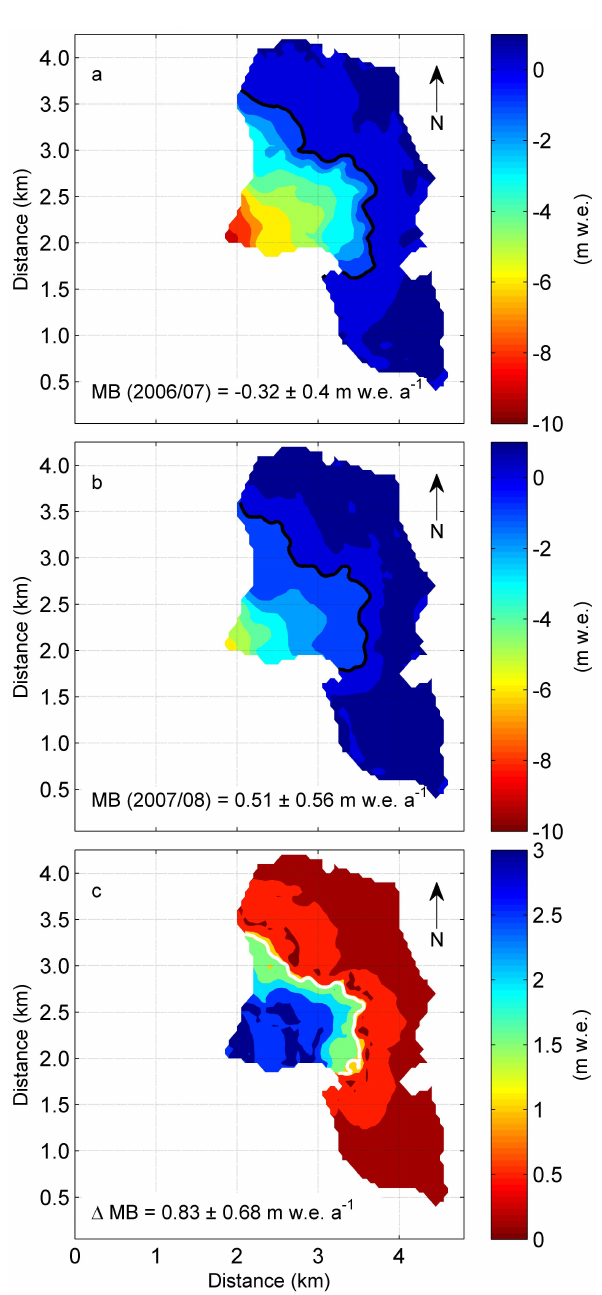
Fig. 6. Annual mass balance for (a) September 2006 to August 2007 and (b) September 2007 to August 2008, showing the ELA as a black line. Given uncertainty values only reflect uncertainties in internal model parameter values (Sect. 2.2.3). (c) Difference in annual mass balance between year 2 and year 1. Differences below (in sense of altitude, Fig. 1) the white line are significant above the 95% confidence